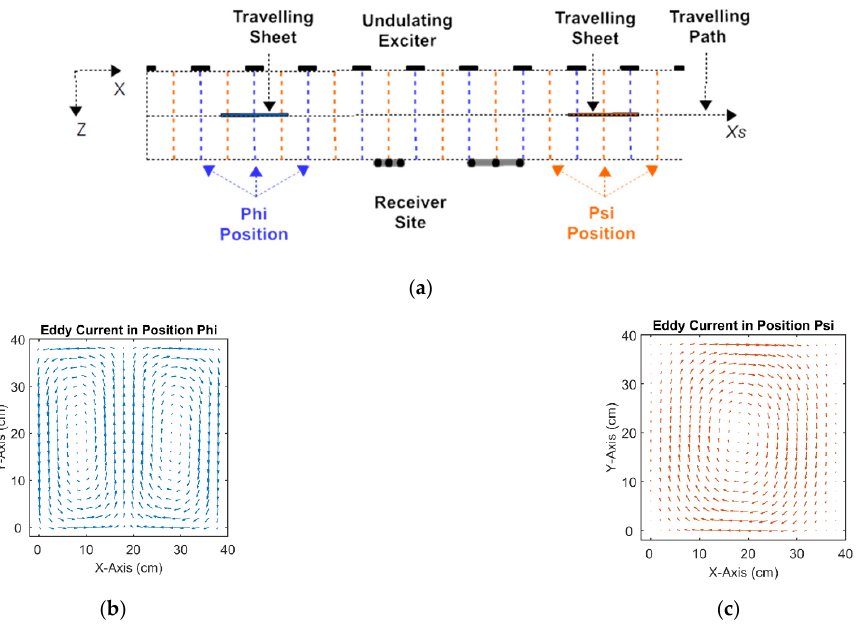
Figure 2 . Planar MIT system and excited eddy currents: ( a ) Top view. The traveling 3D body or 2D test sheet moves in the X direction through the measuring range between the undulator and butterfly receiver array; ( b ) Homogenous 2D sheet in scan position Phi and eddy currents. Higher current densities in the center region are also preserved for 3D bodies; ( c ) Homogeneously conducting 2D sheet in scan position Psi.